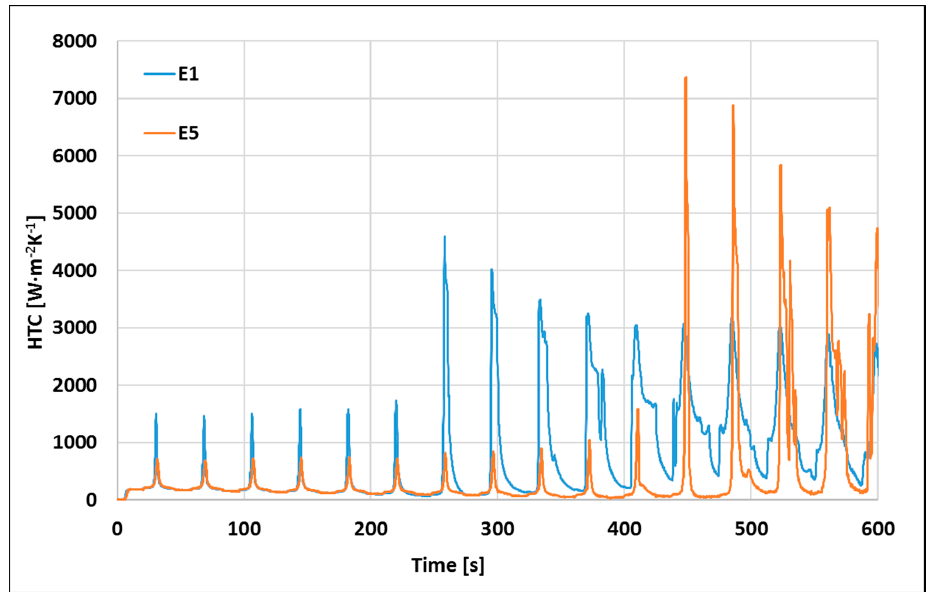
Figure 4. HTC vs. time on the nozzle axis (position A) for experiment E1 and E5. Relative position of the nozzle and test plate was recorded during the experiment. This allows to use distribution of HTC on the cooled surface for evaluation. The averaged HTC distribution for all experiments is shown in Figure 5.